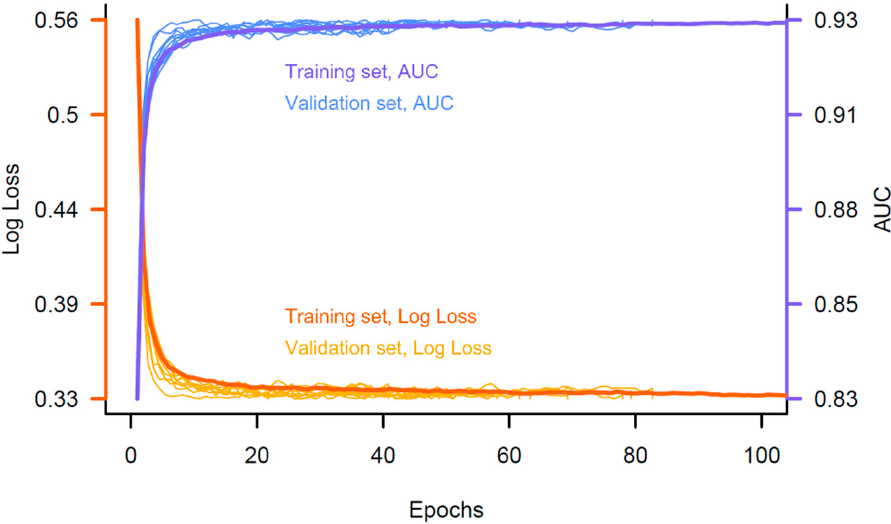
Figure 5. Learning curves showing performance of classification during the epochs. Performance is shown as log loss and area under curve (AUC), measured on the training and validation datasets (in darker and lighter colours, respectively). The similar pattern measured for the two datasets suggests that the performance learned through the training set was generalised to the validation set, thus indicating no overfitting